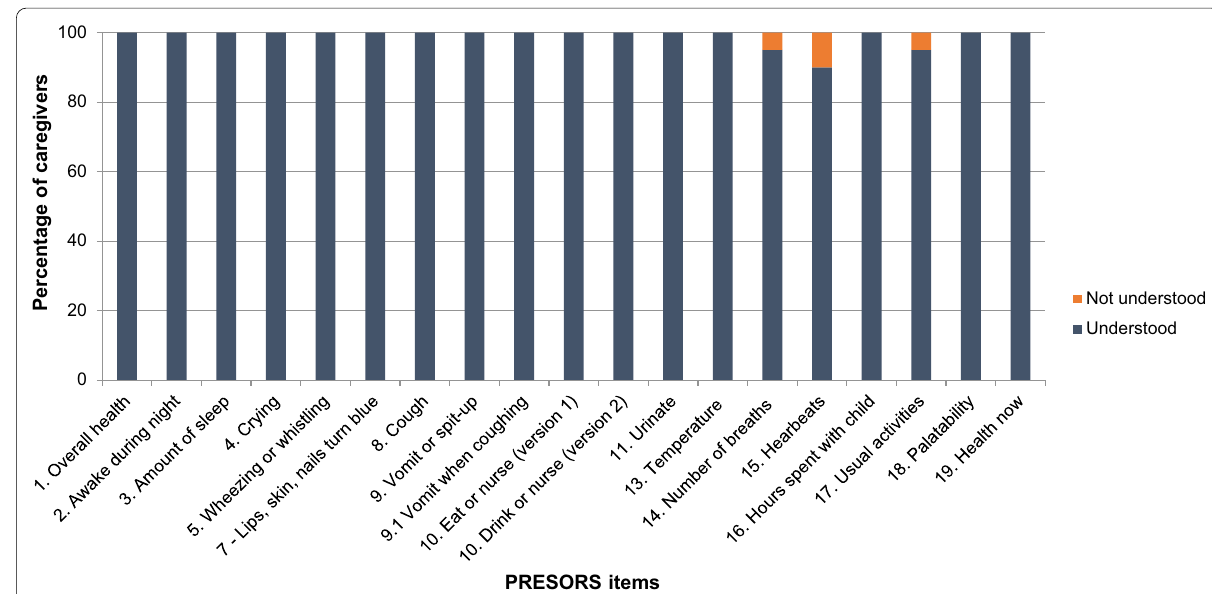
Fig. 2 Overview of participant understanding for PRESORS ObsRO v4.0 items (n 21). Note Items 6.1, 6.2, 6.3 (breathing difficulties) and 12 = (dehydration) are not included in figure. Sample sizes vary for particular items due to a skip pattern (item 9.1 [n due to time limitations (items 15 [n 20]; Items 16 – ‑19 [n 19]; or different versions of the same item were debriefed (item 10 version 1 [n = = Item 10 version 2 [n 13] =